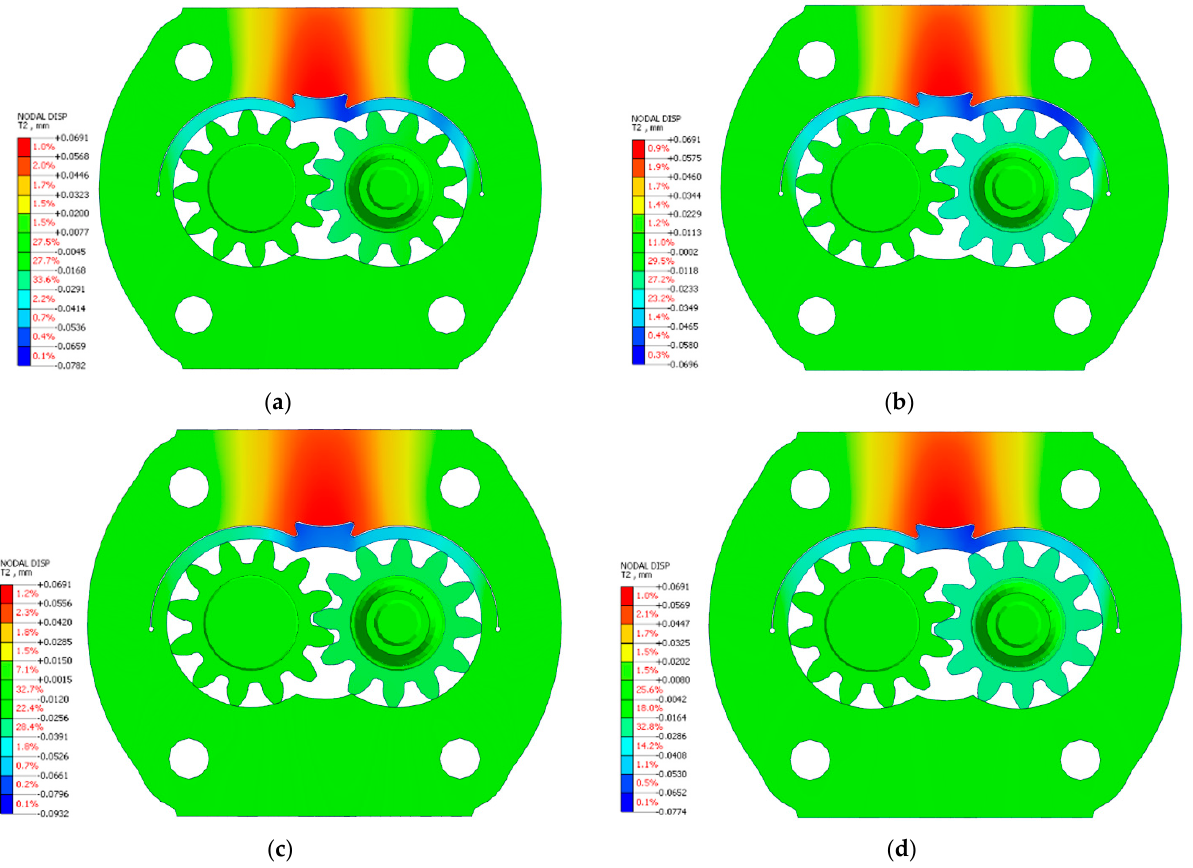
Figure 13. Distribution of displacements in the Y-axis in casing A, gear rotation angle: ( a ) 0°, ( b ) 7.5°, ( c ) 15°, ( d ) 22.5°.